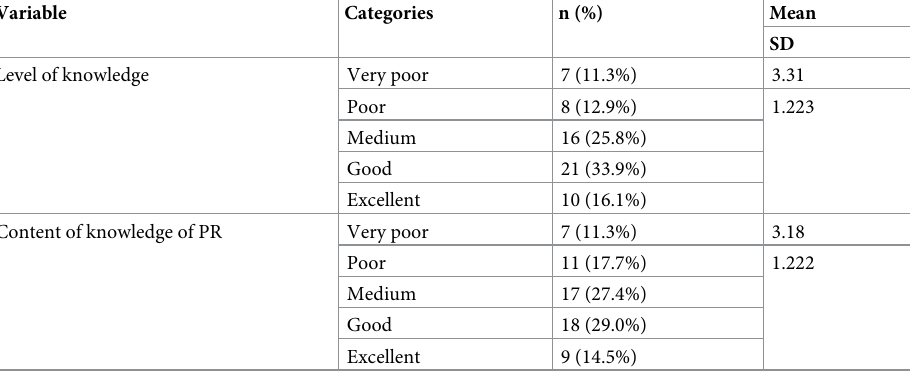
Table 2. Knowledge of chest physicians about pulmonary rehabilitation (PR), N = 62.